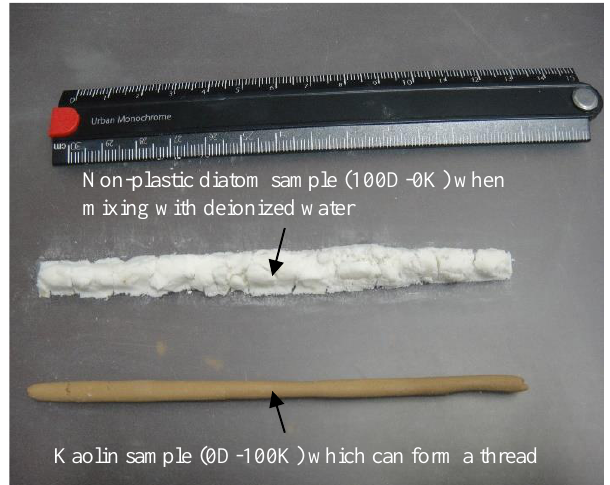
Kaolin sample (0D-100K) which can form a thread Figure 2. The successful case of kaolin and failed attempt of diatoms to form a thread.